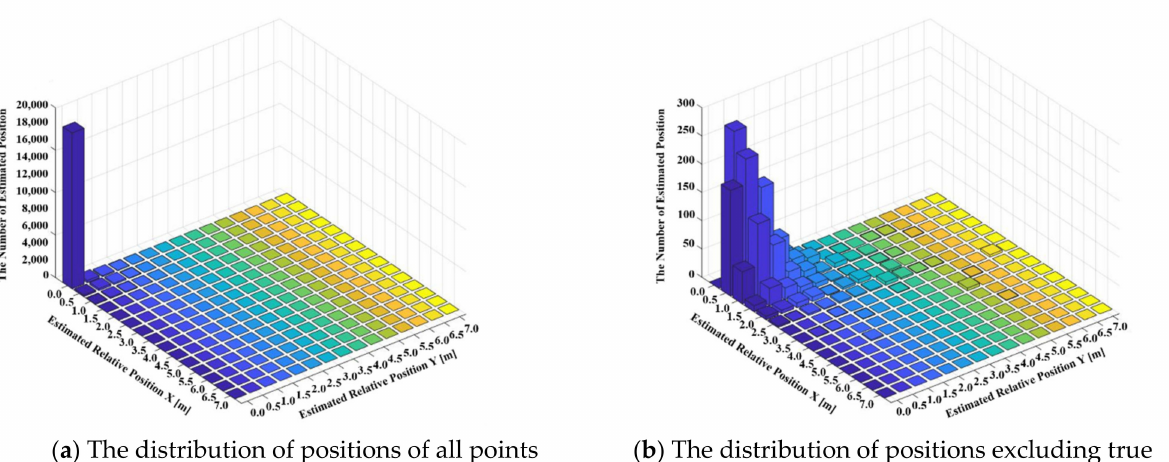
Figure 13. Estimated position distribution relative to ground